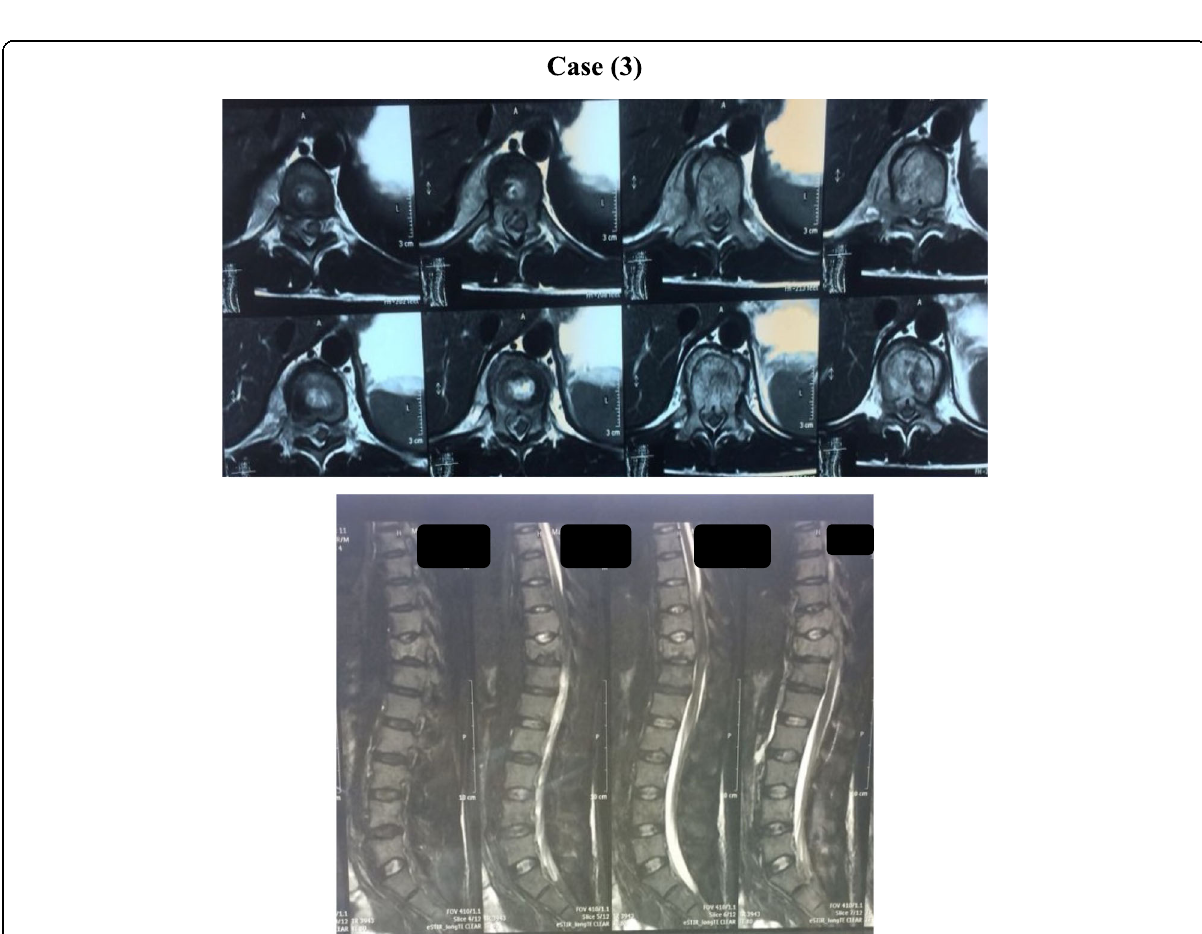
Fig. 11 MRI of the dorsolumbar spine in a 30-year-old male patient with a history of retroperitoneal sarcoma shows dorsal 10 – 11 metastatic lesion